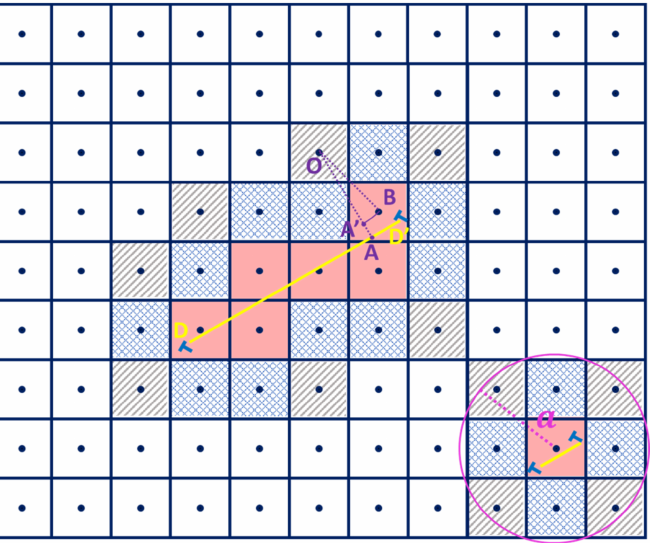
Figure 2. Schematic of distributing plastic strain to integration points of the FEM. The black points represent integration points. The red areas and the shaded areas are the core domains and secondary domains, respectively.